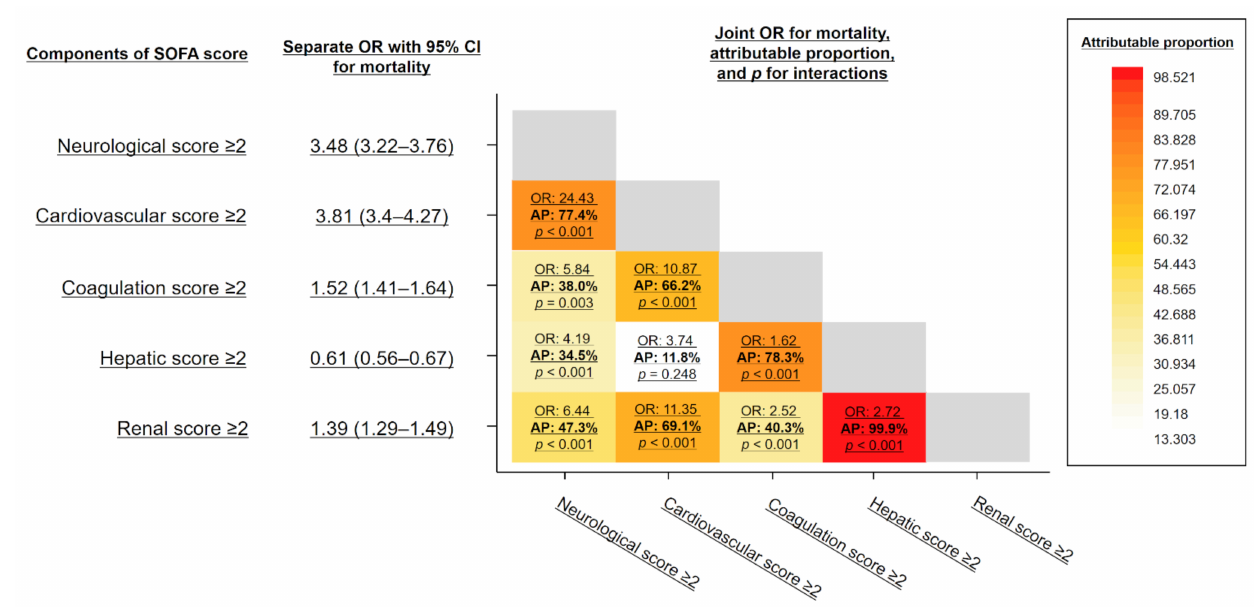
Figure 4. Heat map corresponding to the attributable proportion of the joint effects to interaction between the increases of two SOFA subscores. Each cell contains the following: (1) on the first line: the joint mortality odds ratios of the simultaneous increase in the two SOFA subscores above 2 points, (2) on the second line: the attributable proportion of the joint effects to interaction between the increases of the two SOFA subscores; and (3) on the third line: the p value for the two-way interactions on mortality between the increase of the two SOFA subscores. The color key histogram shows the attributable proportion to interaction within each color bar. CI: Confidence Interval, OR: Odds Ratio, SOFA: Sequential Organ Failure Assessment, AP: Attributable